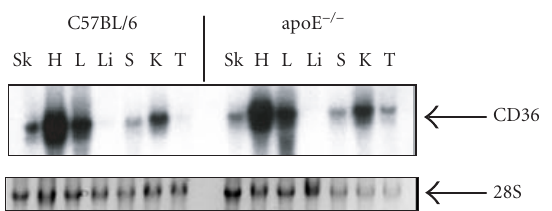
(a) Representative northern blot showing transcription levels of CD36 in skeletal muscles (Sk), heart (H), lung (L), liver (Li), spleen (S), kid- ney (K) and testis (T) of apoE deficient mice, in comparison to wild type (C57BL/6). Blots contained 20 µ g of total RNA. A control for loading and for quantification (28S) was also used.